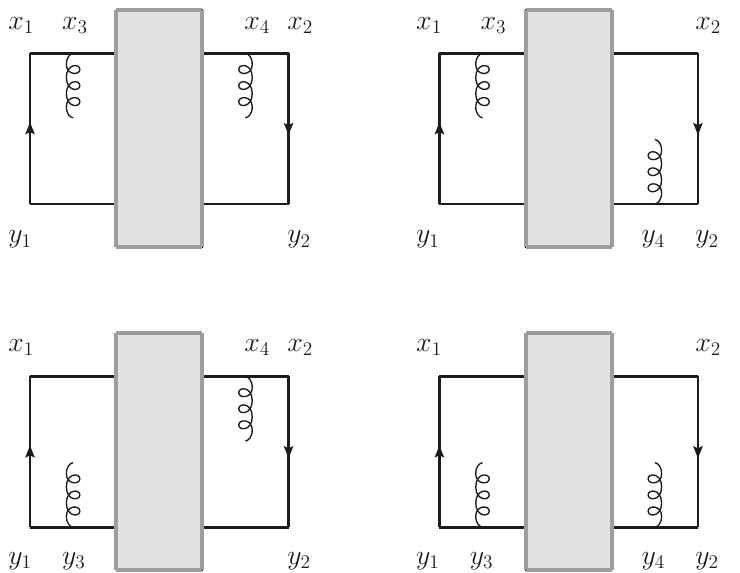
Figure 3 . Illustration of the 4 topologies contributing to eq. (3.39) where the first and last in- teractions with the background field are extracted. The gray boxes represent higher order gluon exchanges with the target as shown in figure